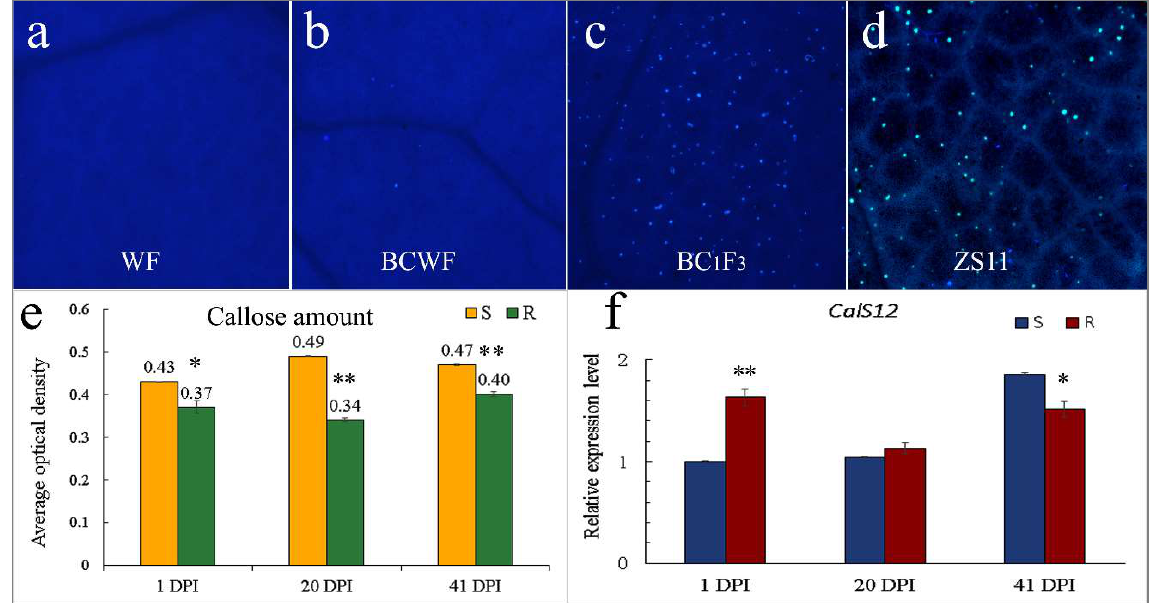
Figure 4. Infection-induced callose deposition and expression levels of two genes encoding callose synthases in the plants. Representative images for callose (particles stained with Aniline Blue) deposited on leaf surface of penetration-resistant ‘WF’ ( a ), highly resistant ‘BCWF’ ( b ), moderately resistant plant in the BC 1 F 3 population ( c ) and the susceptible cultivar ‘ZS11’ ( d ) after inoculation with PM. ( e ) Callose deposition on the leaves of susceptible/resistant (S/R) plants in the BC 1 F 3 population, quantified as fluorescence intensity per unit of the infiltrated leaf surface. Values represent means + SE of 10 different leaf samples. The expression levels of CalS12 genes ( f ). Asterisks indicate statistically significant differences according to Student’s t -test (* and **, p < 0.5 and 0.01).